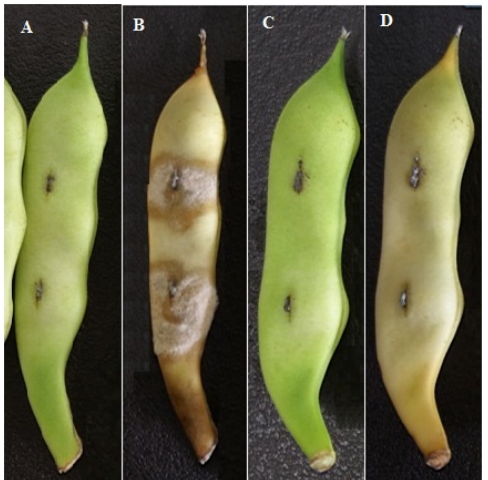
Figure 3. Evaluation of biocontrol abilities of three yeast strains and their combinations against Bo- trytis cinerea in vivo. ( A ) Control group: Snap beans treated with 2 wounds and sterilized water inoculated with Botrytis cinerea after 3 days; ( B ) Control group: Snap beans treated with 2 wounds and sterilized water inoculated with Botrytis cinerea after 12 days; ( C ) Treated group: Snap beans treated with 2 wounds and Ca63 + Ca64 inoculated with Botrytis cinerea after 3 days; ( D ) Treated group: Snap beans treated with 2 wounds and Ca63 + Ca64 inoculated with Botrytis cinerea after 12 days.